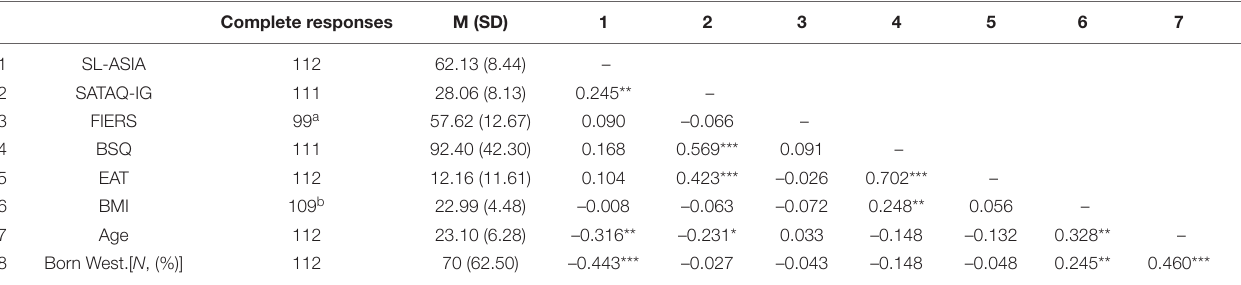
TABLE 2 | Descriptive statistics and Pearson correlations for each variable of